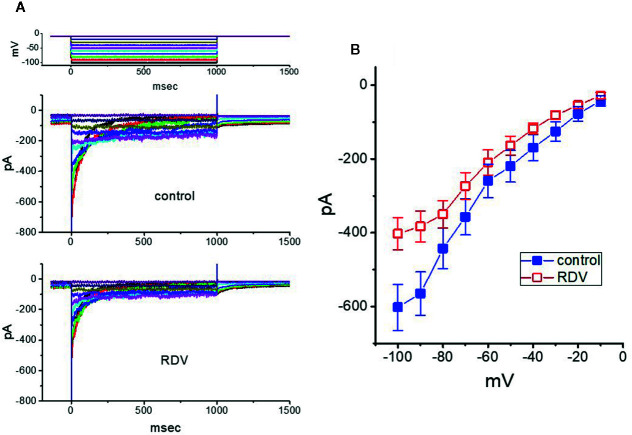
Effect of RDV on erg-mediated K+ current (I
K(erg)) enriched in GH3 cells. The experiments were undertaken in cells bathed in high-K+, Ca2+-free solution, and we filled the electrode using K+-containing solution. (A) Superimposed I
K(erg) traces elicited by a series of voltage pulse as indicated in the uppermost part of (A). The traces in the upper part are controls (i.e., RDV was not present), and those in the lower part was obtained 2 min after application of 30 μM RDV. (B) Averaged I-V relationships of I
K(erg) obtained in the absence (■) and presence (□) of 30 μM RDV (mean ± SEM; n=9 for each point). Current amplitude was obtained at the beginning of each hyperpolarizing command pulse.